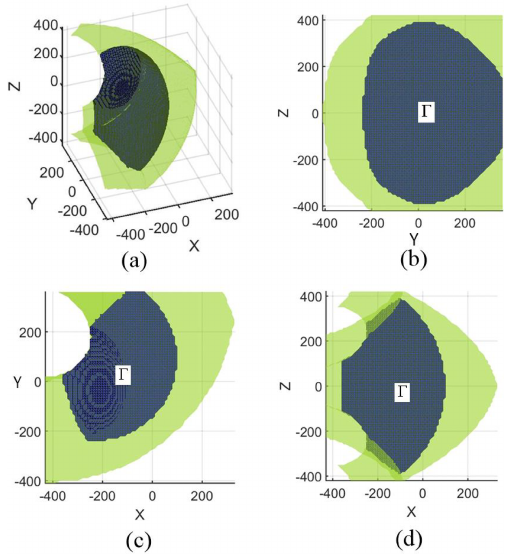
Figure 15. Efficient workspace (cid:48) where GTI ≥ 0.7: (a) oblique view, (b) front view, (c) top view, (d) side